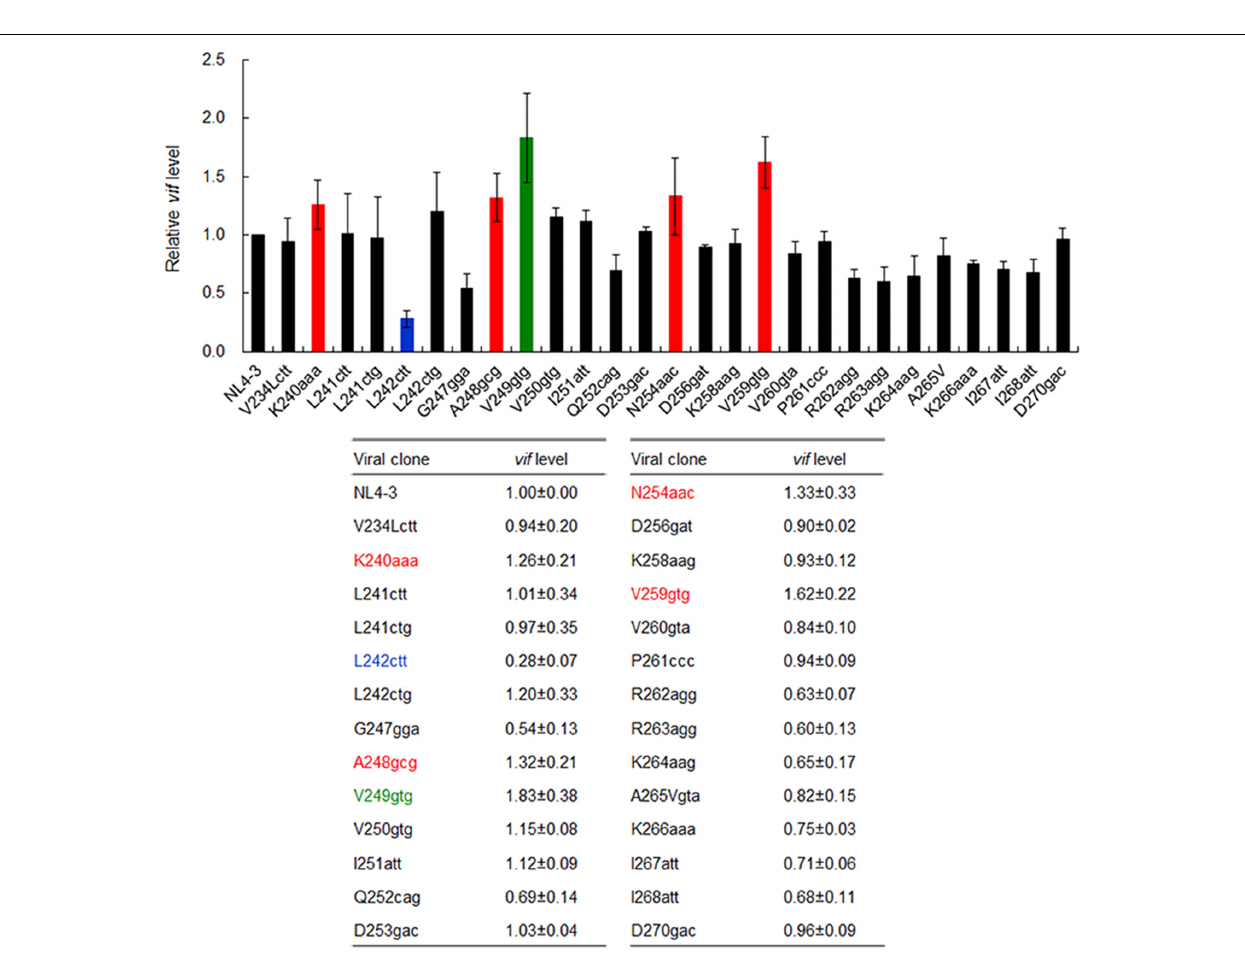
FIGURE 3 | Effects of nSNVs in SA1D2prox on vif expression. Proviral clones indicated were transfected into 293T cells, and at 20 h post-transfection, total RNAs were prepared. After DNase I-treatment, samples were subjected to qRT-PCR analysis by a specific primer set for vif transcript ( Figure 1 ). For clones designated K240aaa, L242ctt, A248gcg, V249gtg, N254aac, and V259gtg, cDNA samples synthesized using DNase I-treated RNA and oligo (dT) primer were subjected to qRT-PCR analysis. Expression levels of all HIV-1 transcripts/mRNAs and GAPDH transcript/mRNA were analyzed by qRT-PCR in parallel as transfection and internal controls, respectively. A vif expression level in each sample was normalized by those of all HIV-1 transcript/mRNA species and GAPDH transcript/mRNA. Vif expression levels relative to that by NL4-3 are presented. Blue letters/bar, red letters/bars, and green letters/bar indicate low, high, and excessive vif types (Nomaguchi et al., 2016), respectively. Mean values ± SD from four independent experiments are